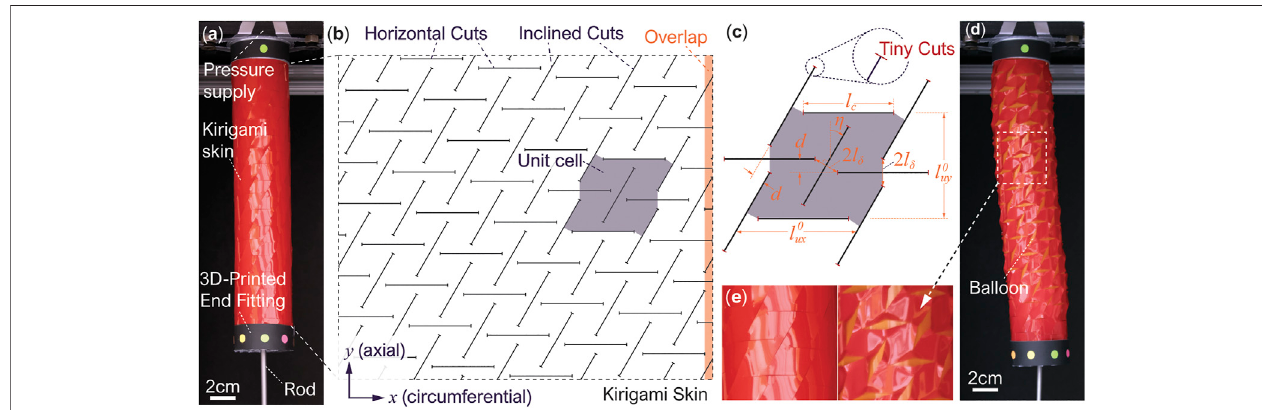
FIGURE 1 | The overall concept, design, and fabrication of the kirigami-skinned actuator. (A) The actuator at rest, showing its different components. (B) The unwrapped kirigami skin showing the cut pattern. Here, a unit cell and the overlapping region for skin wrapping are highlighted. (C) The detailed geometry of a unit cell showing the different design parameters. Notice the additional “ tiny cuts ” at the tips of horizontal and inclined cuts to increase the skin ’ s mechanical strength. (D) The pressurizedactuatorshowingbothextensionandtwistingmotion(noticethecolormarkers ’ movementontheend fi tting).Theslightbendingisduetotheadditional skin stiffness from the overlapping region, and it is not considered in our kinematics model. (E) A close-up view showing the skin ’ s complex in-plane and out-of-plane deformations.